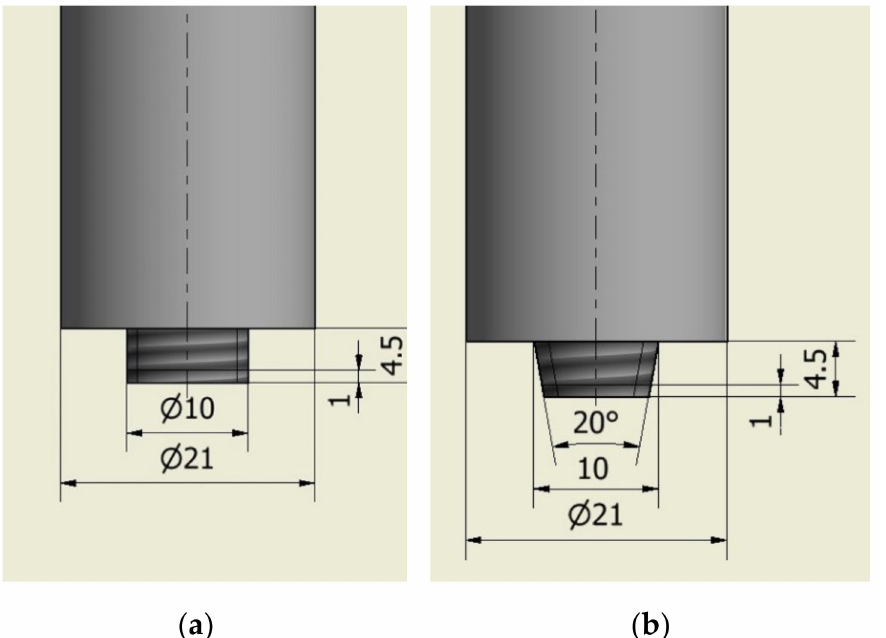
Figure 1. Sketch of tool pin shapes (dimensions in mm): ( a ) cylindrical threaded, ( b ) tapered